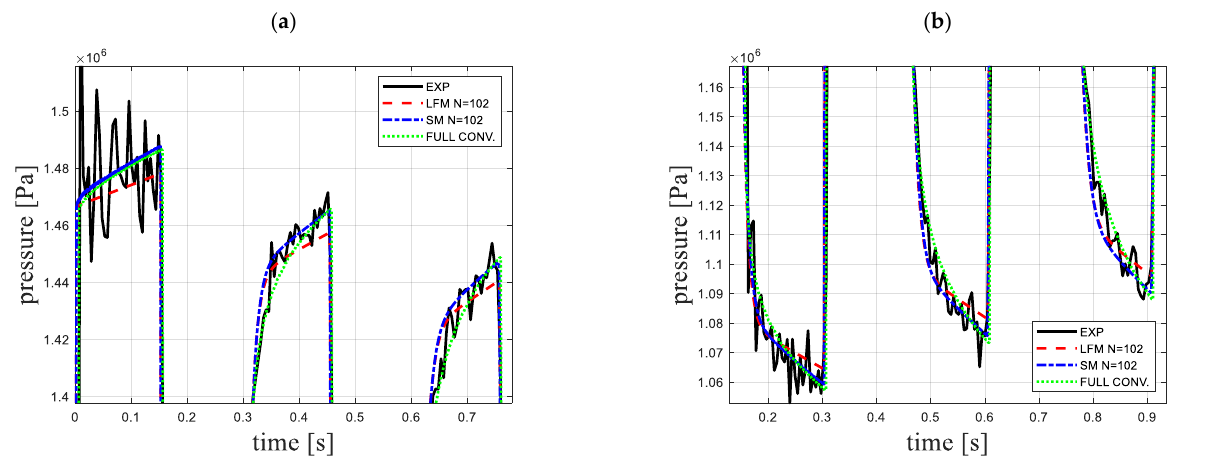
Figure 7. Selected results of pressures histories for Case 02 ( Re = 2750): ( a ) initial phase; ( b ) later phase.